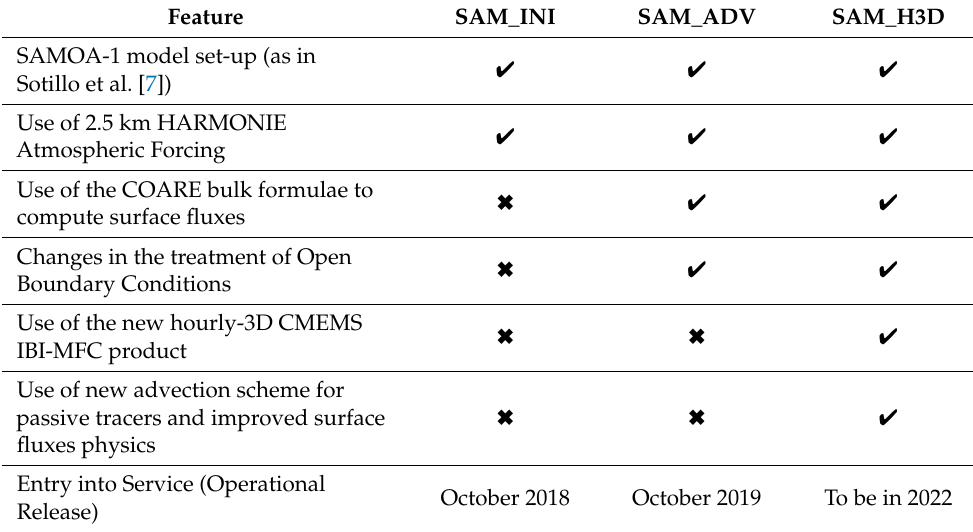
Table 1. Summary of the main differences among the sensitivity tests conducted. The columns denote the three SAMOA model configurations (SAM_INI, SAM_ADV and SAM_H3D) and the rows the different upgrades. (cid:52) means included in each model set-up, and (cid:54) not